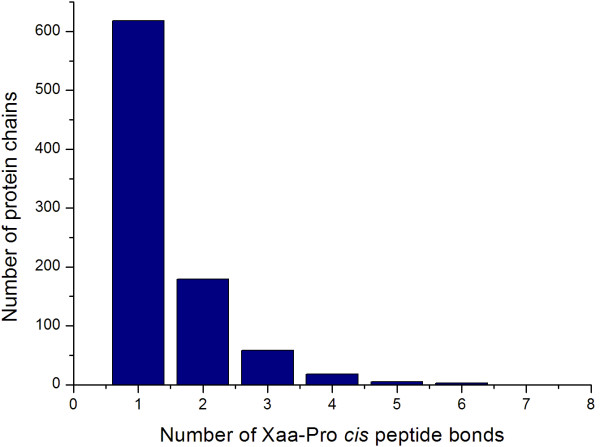
Distribution of the Xaa-Pro cis peptide bonds per protein sequences in the dataset. Protein chains are grouped according to the number of Xaa-Pro cis peptide bonds.